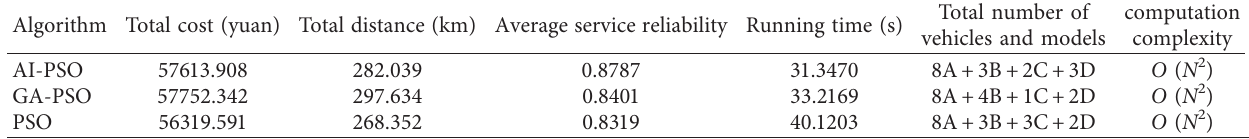
Table 10: Three methods are used to calculate the results in the static